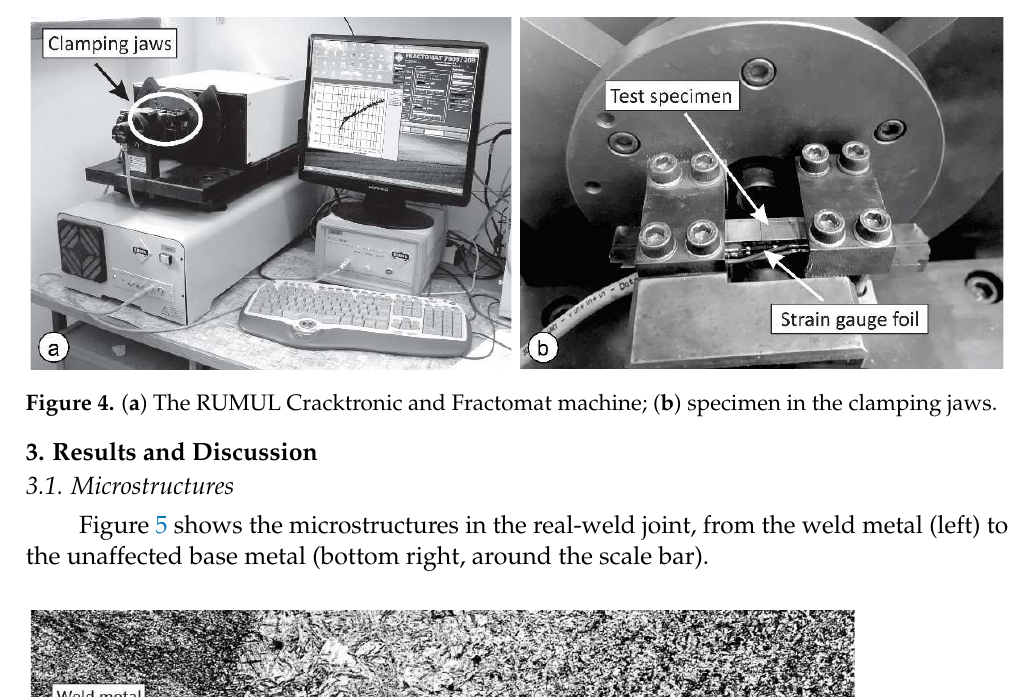
Figure 4. ( a ) The RUMUL Cracktronic and Fractomat machine; ( b ) specimen in the clamping jaws.